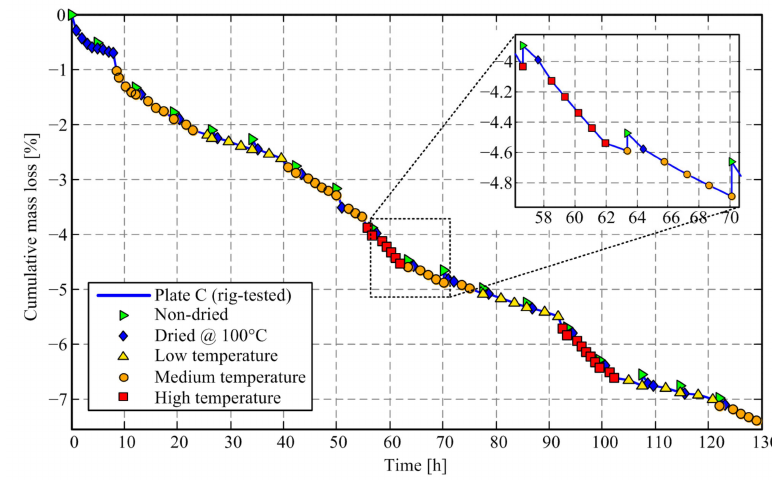
Figure 6. Comparative time response of cumulative mass loss of rig-tested friction plate C.